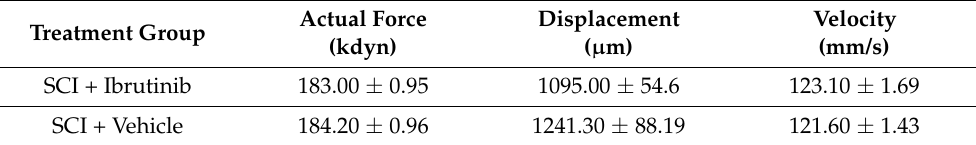
Table 1. Injury Parameters. Values are mean ± SEM. No significant differences in impact force, displacement, and velocity were found between the Ibrutinib treatment and vehicle groups ( n = 10 per